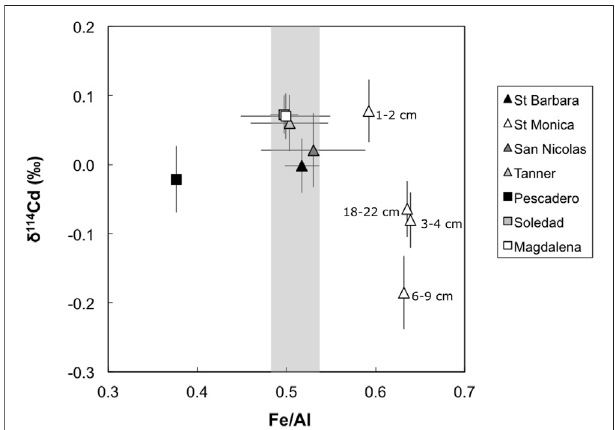
FIGURE 5 | Site-averaged bulk sediment Fe/Al vs. δ 114 Cd values, except for Santa Monica where all data points are shown (white triangles). Shaded gray bar represents the Fe/Al ratio of the upper continental crust (UCC; Rudnick and Gao, 2003). Note that Fe/Al ratios are enriched at SantaMonica(anddepletedat thePescaderoslope) compared toUCC.Error bars for site average are 1 standard deviation of the entire sediment column and error bars for SantaMonica are external 2 SD on sample replicates or ofa secondary standard (BAM, ± 0.05 ‰ ), or the internal 2 σ on an individual Cd isotope ratio measurement, whichever is